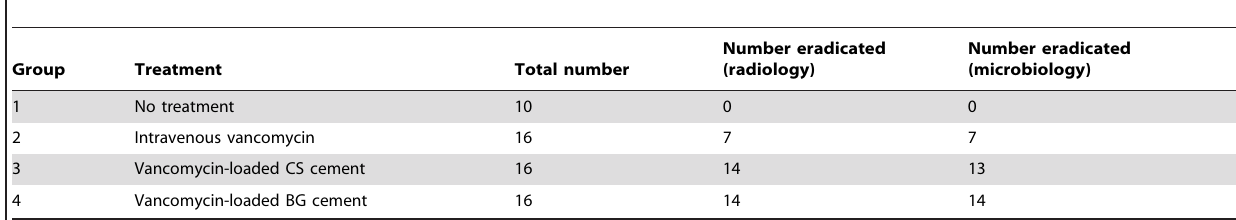
Table 1. Comparison of the capacity of the 4 treatment mentods to eradicate MRSA-induced osteomyelitis in rabbit tibiae at 8 weeks post-surgery.